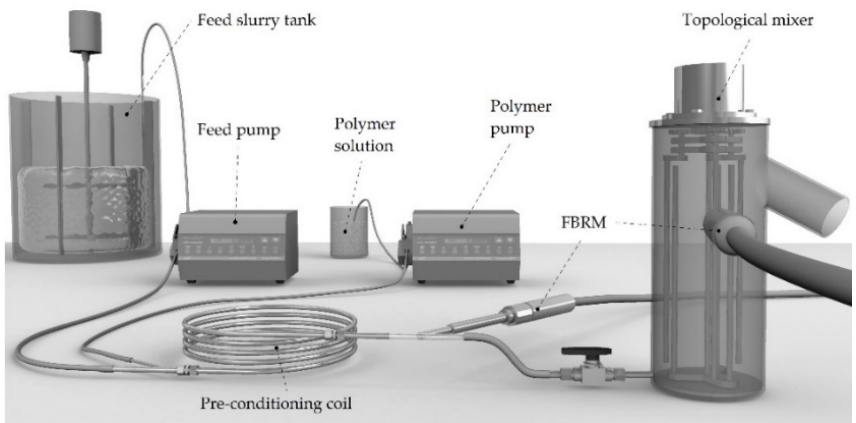
Figure 3. Optimized system to apply tapered shear for polymer addition to high solids suspensions.